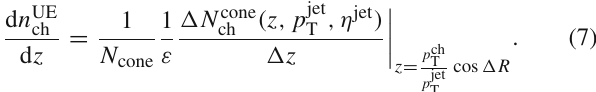
particle transverse momentum, p ch , and z respectively. 5 The T variable ε is the MC-evaluated track reconstruction effi- ciency. The superscript ‘meas’ in Eqs. (4) and (5) indicates that the measured distributions were corrected only for the tracking efficiency. The corrections for the UE and detector effects were applied in the subsequent steps of the analysis as discussed in the next